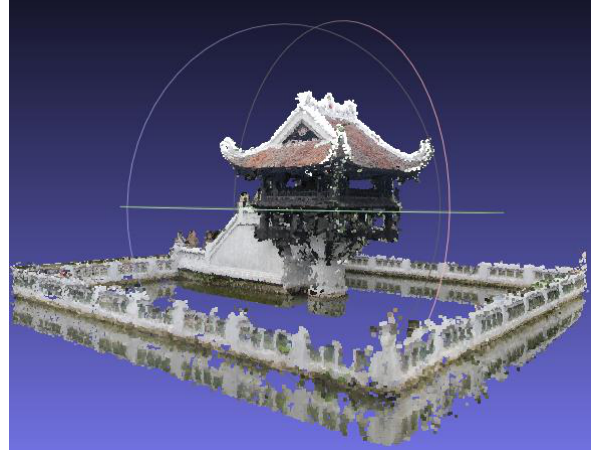
Figure 7. Point cloud processing with MeshLab